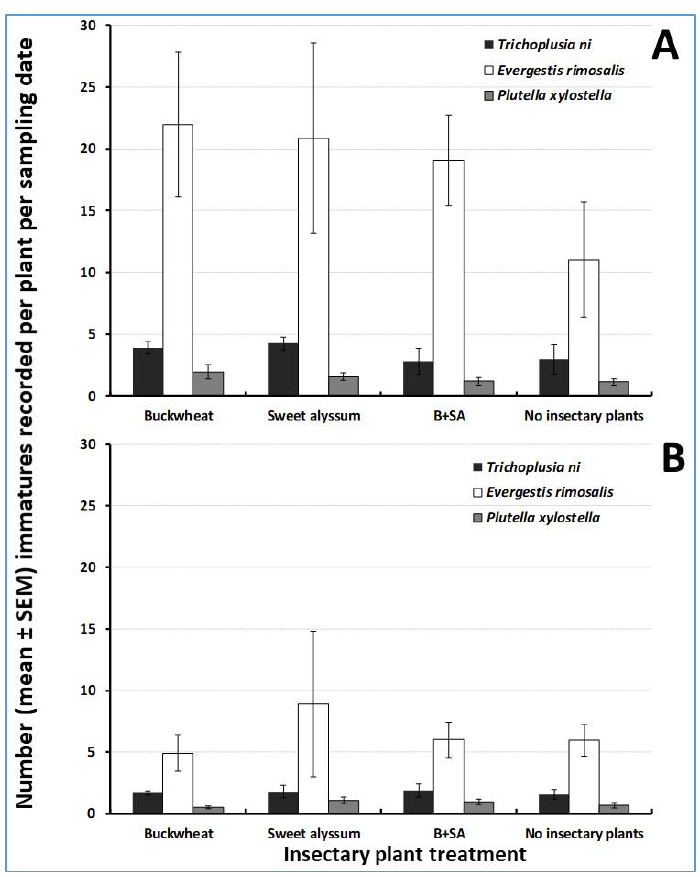
Figure 2. Trap crop herbivore abundance on a per-plant basis: (A) kale and (B) collards. For each herbivore species, there were no significant differences in their abundance on trap crops in response to insectary plant treatment according to ANOVAS and Fisher-protected LSD tests ( p < 0.05).